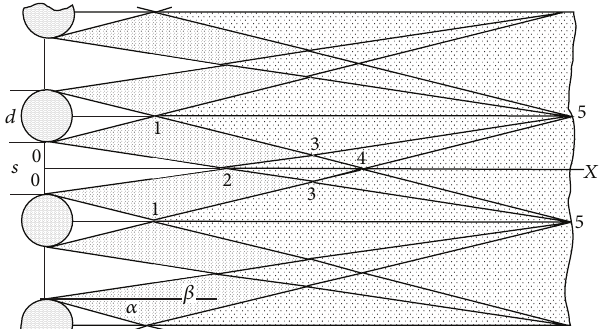
Figure 25: Scheme of flow turbulization behind the obstacles. then along with intersections of the interior boundaries on axes of each body, the exterior boundaries of turbulent layers from the neighboring bodies will be closed also. The intersec- tion point of the exterior boundaries is defined as a distance between bodies and by expansion angle of the exterior boundary (points 2 on Figure 25). The optimization condition was formulated as an equidistantness of intersection points of the interior (1) and exterior (2) boundaries of turbulent layers from a plane of “lattices.” This condition allows to establish an optimum relation between geometric parameters of individual bodies (as elements of the accelerator) in the given cross-section and also to determine the coordinates of following “lattice” with turbulization elements. Such relations represent an engineering technique for purposeful projection of turbulent device for DDT accelerators.